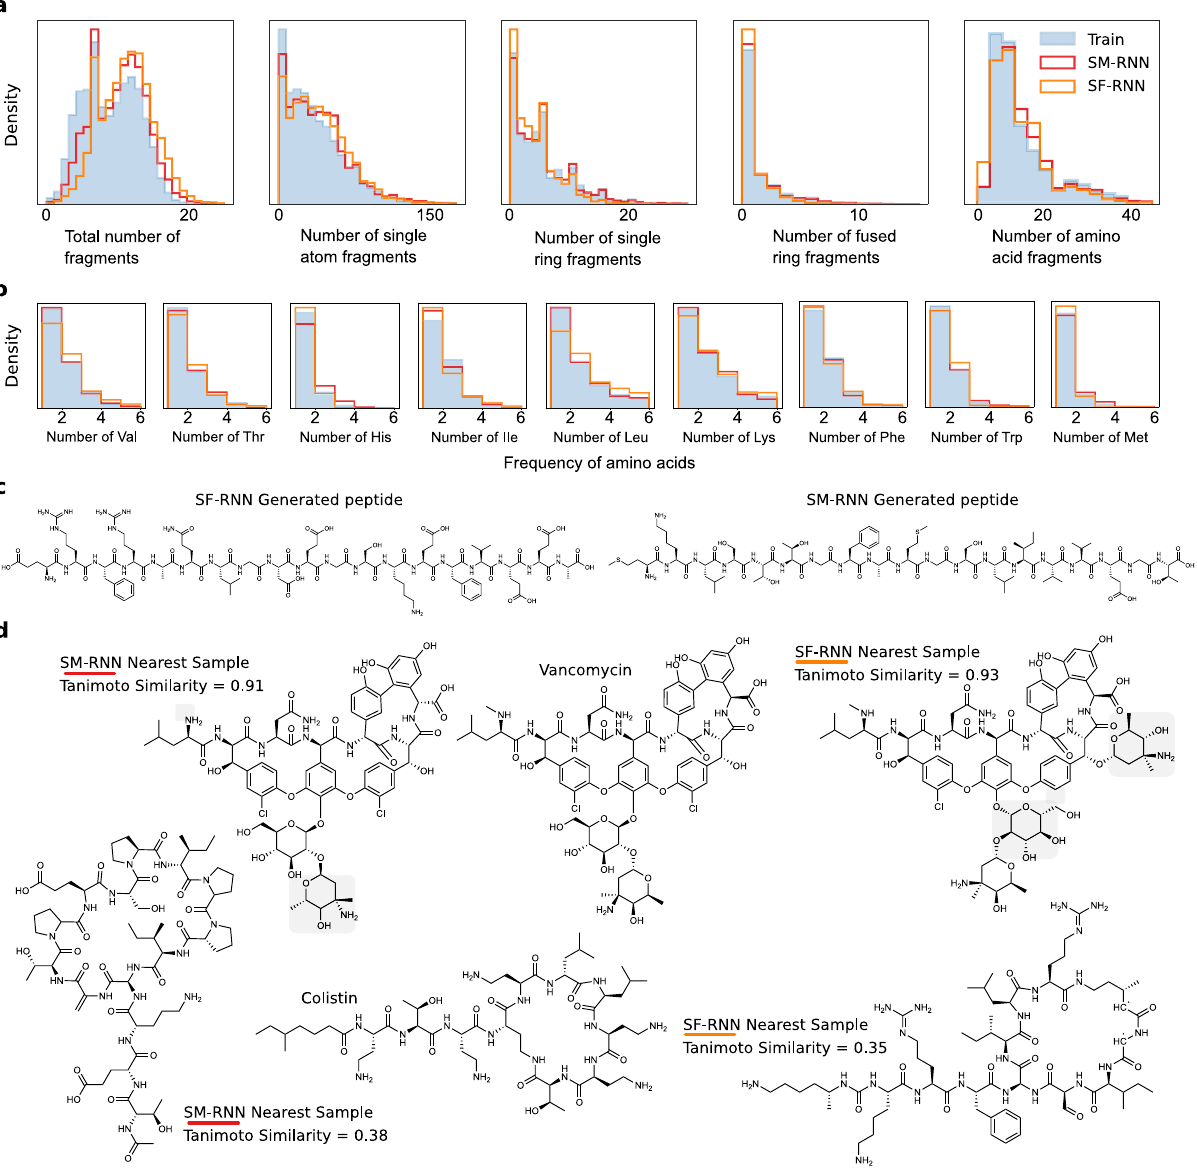
Fig. 6 Large-scale Task II. a Histograms of fragment #, single atom fragment #, single ring fragment #, fused-ring fragment #, amino acid fragment # (all per molecule) from molecules generated by the RNN models or from the training data. b Histograms of speci fi c amino acid number in each molecule generated by the RNNs or from the training data. c A peptide generated by the SM-RNN — MKLSTTGFAMGSLIVVEGT (right) and one generated by the SF- RNN — ERFRAQLGDEGSKEFVEEA (left). d Molecules generated by the SF-RNN and SM-RNN that are closest in Tanimoto similarity to colistin and vancomycin. The light gray shaded regions highlight differences from